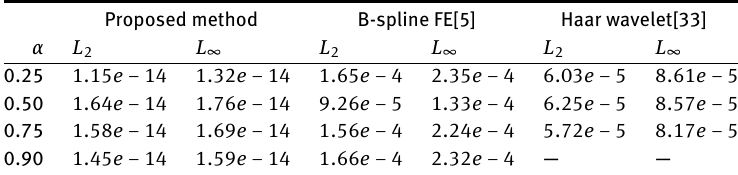
Table 1: A comparison of the proposed method and FE and Haar methods [5, 33] to solve example 1. Proposed method